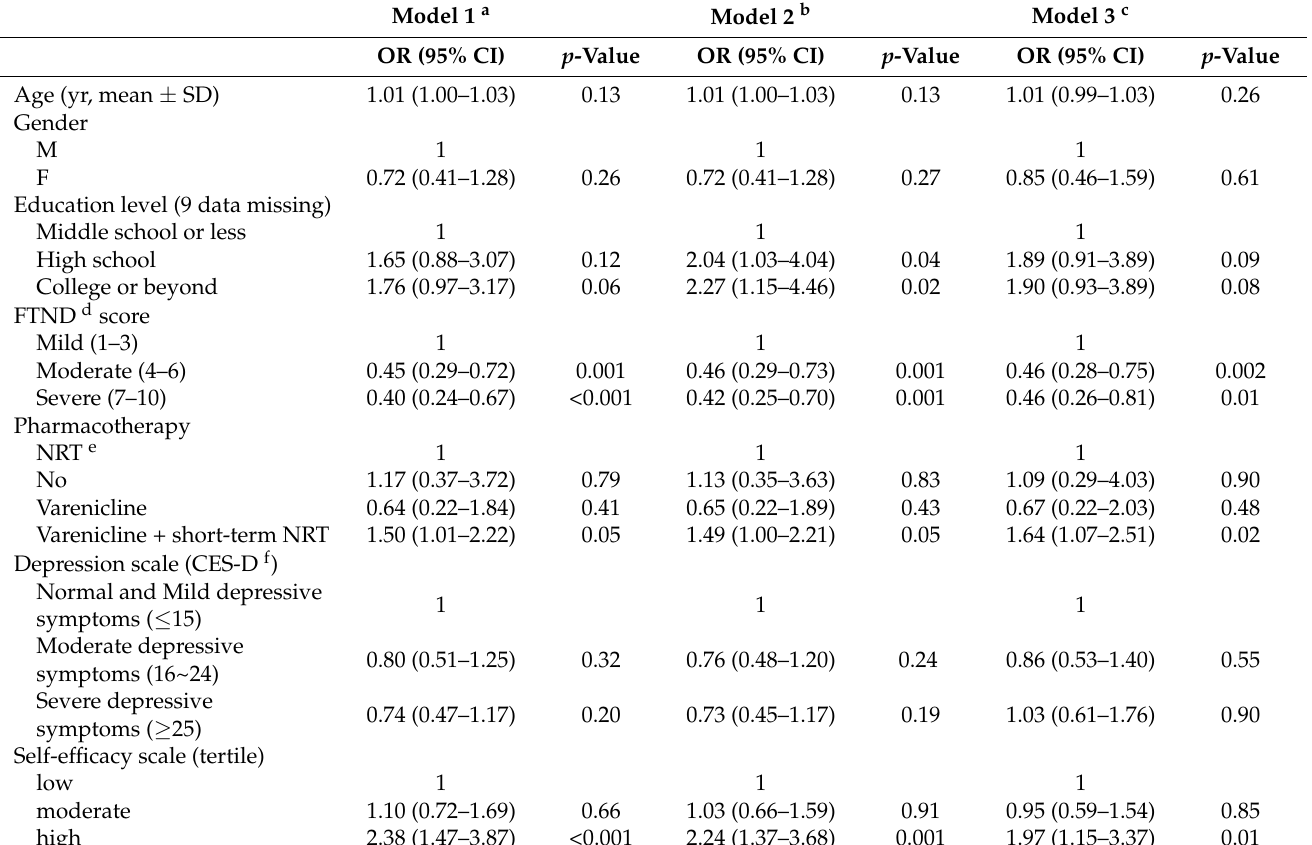
Table 5. Multivariable logistic regression analysis of factors associated with 6 months smoking